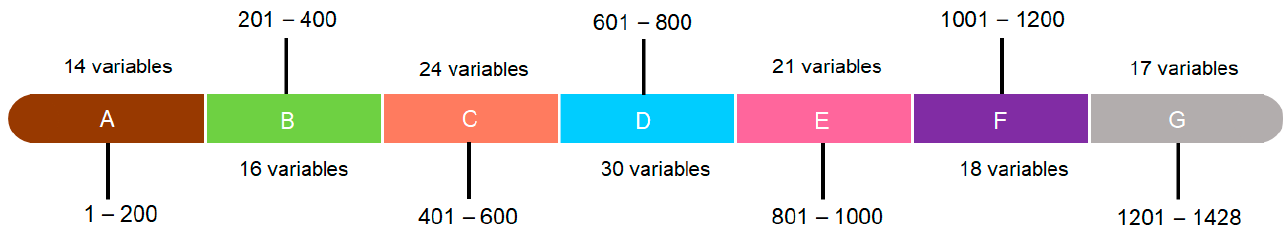
Figure 1. Seven analysed segments of the rbcL sequence for manual design of a primer.